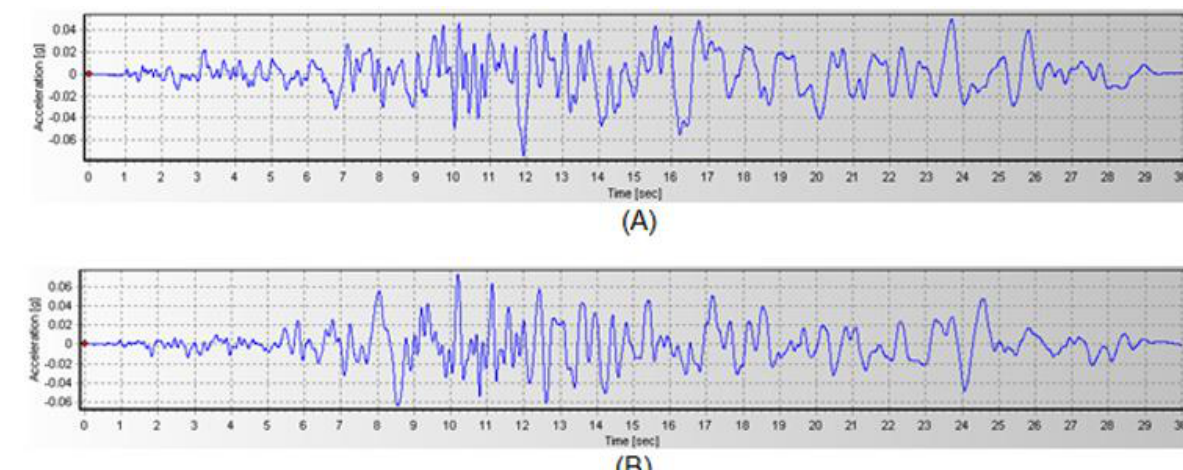
Fig. 9. Couple accelerograms of loma prieta earthquake (A): X and (B): Y